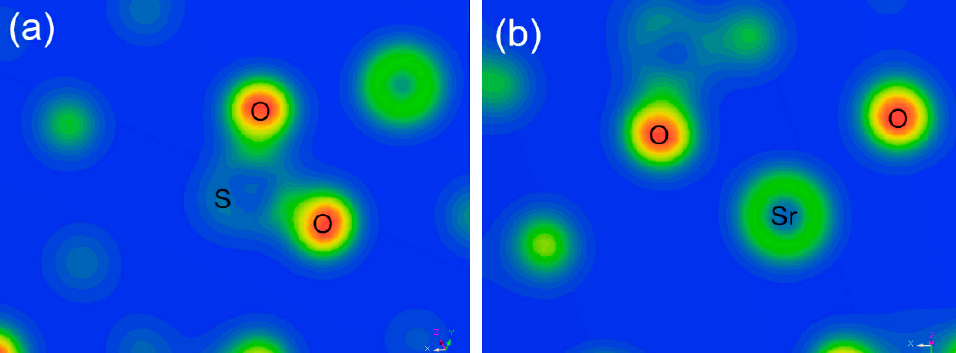
Figure 3. ( a ) Electron density between S–O atoms, ( b ) electron density between Sr–O atoms. Table 2. Mulliken bond population of celestite.